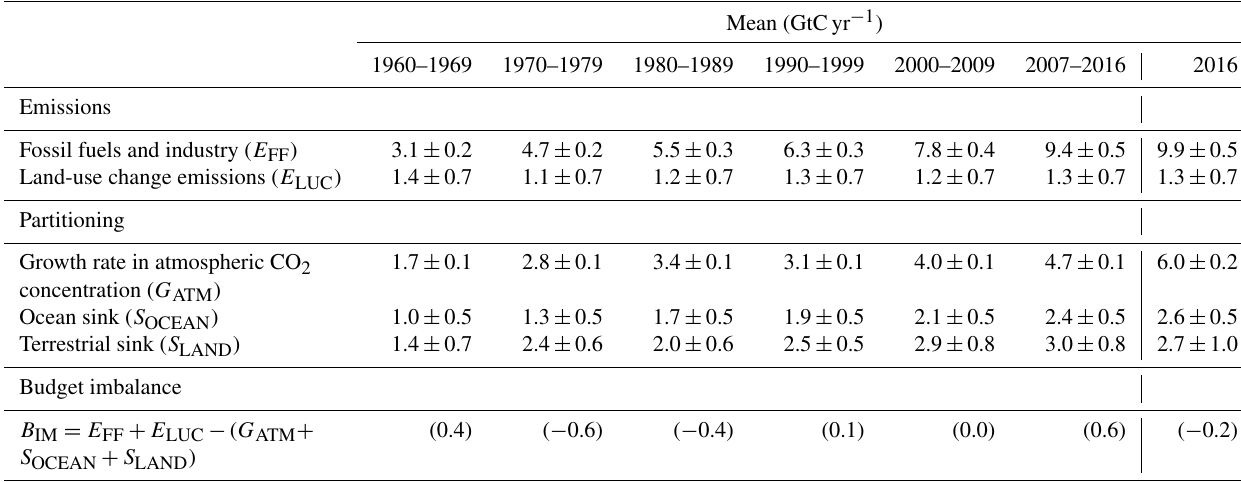
Table 6. Decadal mean in the five components of the anthropogenic CO 2 budget for different periods and last year available. All values are in GtCyr − 1 , and uncertainties are reported as ± 1 σ . Unlike previous versions of the global carbon budget, the terrestrial sink ( S LAND ) is now estimated independently from the mean of DGVM models. Therefore, the table also shows the budget imbalance ( B IM ), which provides a measure of the discrepancies among the nearly independent estimates and has an uncertainty exceeding ± 1GtCyr − 1 . A positive imbalance means the emissions are overestimated and/or the sinks are too